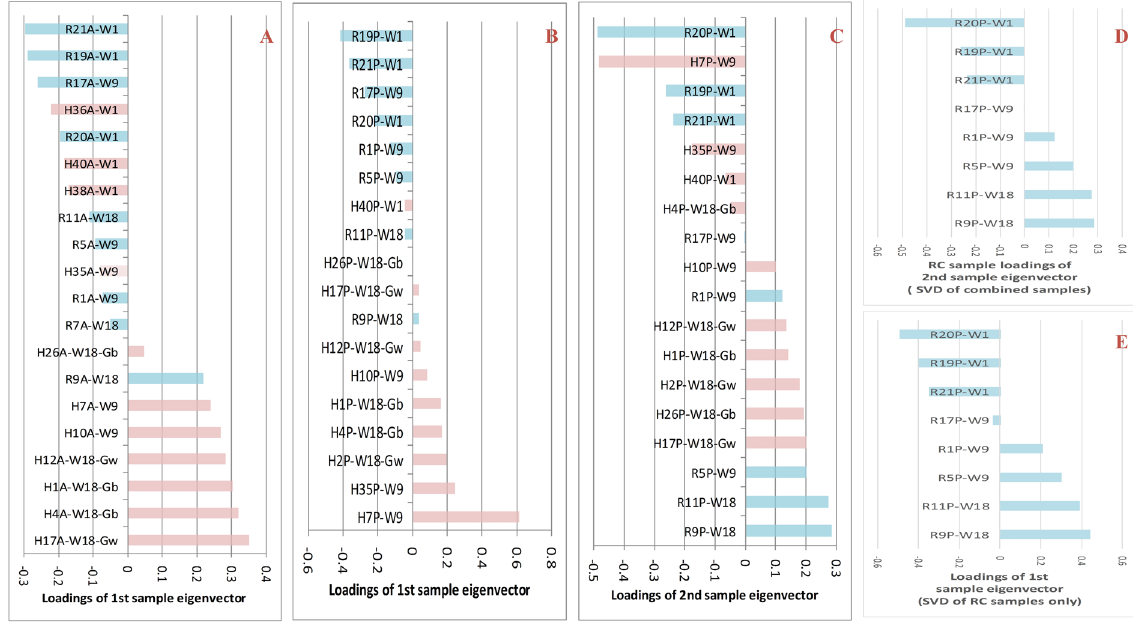
Figure 3. The sorted loadings of the top sample eigenvectors from the adipose and the pancreas and their interpretations. ( A ) The adipose top sample eigenvector v were highly correlated with the age factor, and after 1 week 9 its correlation with the diet factor becomes more significant. ( B ) The pancreatic first eigenvector v from 1 the SVD of all RC and HFD samples. Most RC samples were at the top half whereas most HFD samples were at the bottom half. It indicates that the pancreatic first eigen-component reflected predominantly the HFD impact. ( C ) The sorted loading of the pancreatic second eigenvector from the SVD of all RC and HFD samples. ( D ) Derived from ( C ) by keeping only RC samples. ( E ) When SVD was carried out only for the RC pancreatic samples, the sorted loadings of its first sample eigenvector displayed a chronological order. The exact consistency between ( D ) and ( E ) indicates that the pancreatic second eigen-component reflected predominantly the pancreatic development over